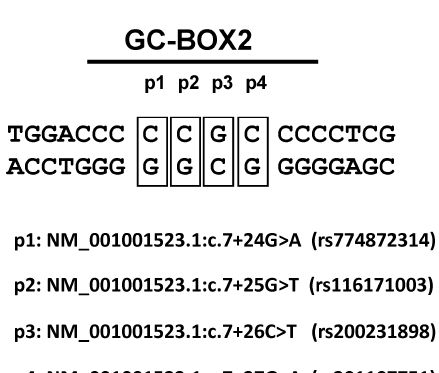
Figure 1. GC-Box 2 within the RAR-related orphan receptor gamma ROR γ T promoter identified using MatInpector Software [19]. Single nucleotide polymorphisms were found in National Center for Biotechnology Information (NCBI) Variation Resources [14].